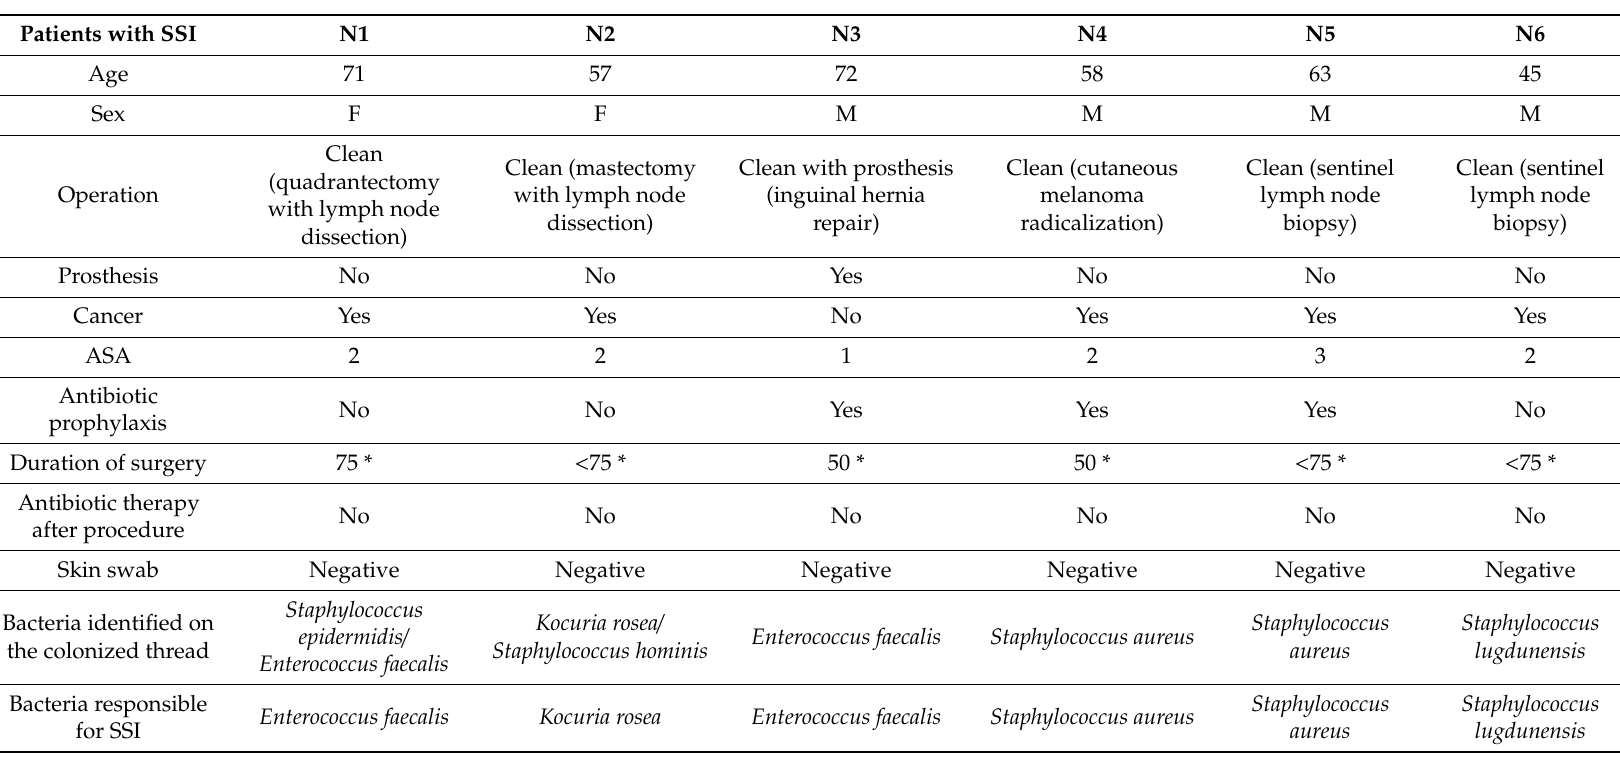
Table 3. Characteristics of patients with a surgical site infection (SSI), and correlation between bacteria isolated on the colonized thread and bacteria responsible for SSI. Patients with SSI N1 N2 N3 N4